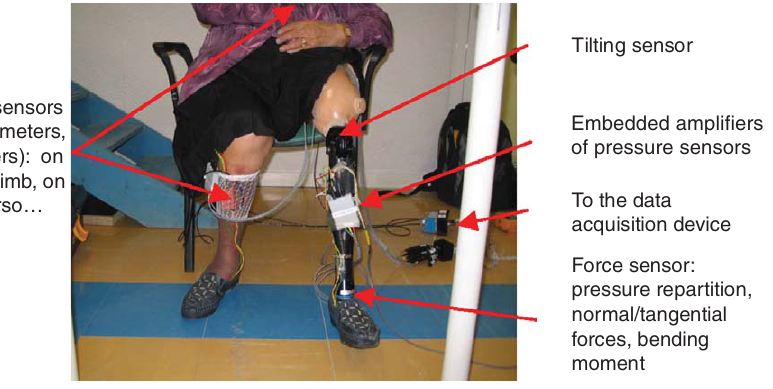
Fig. 4. One patient equipped with the prosthetic knee and motion